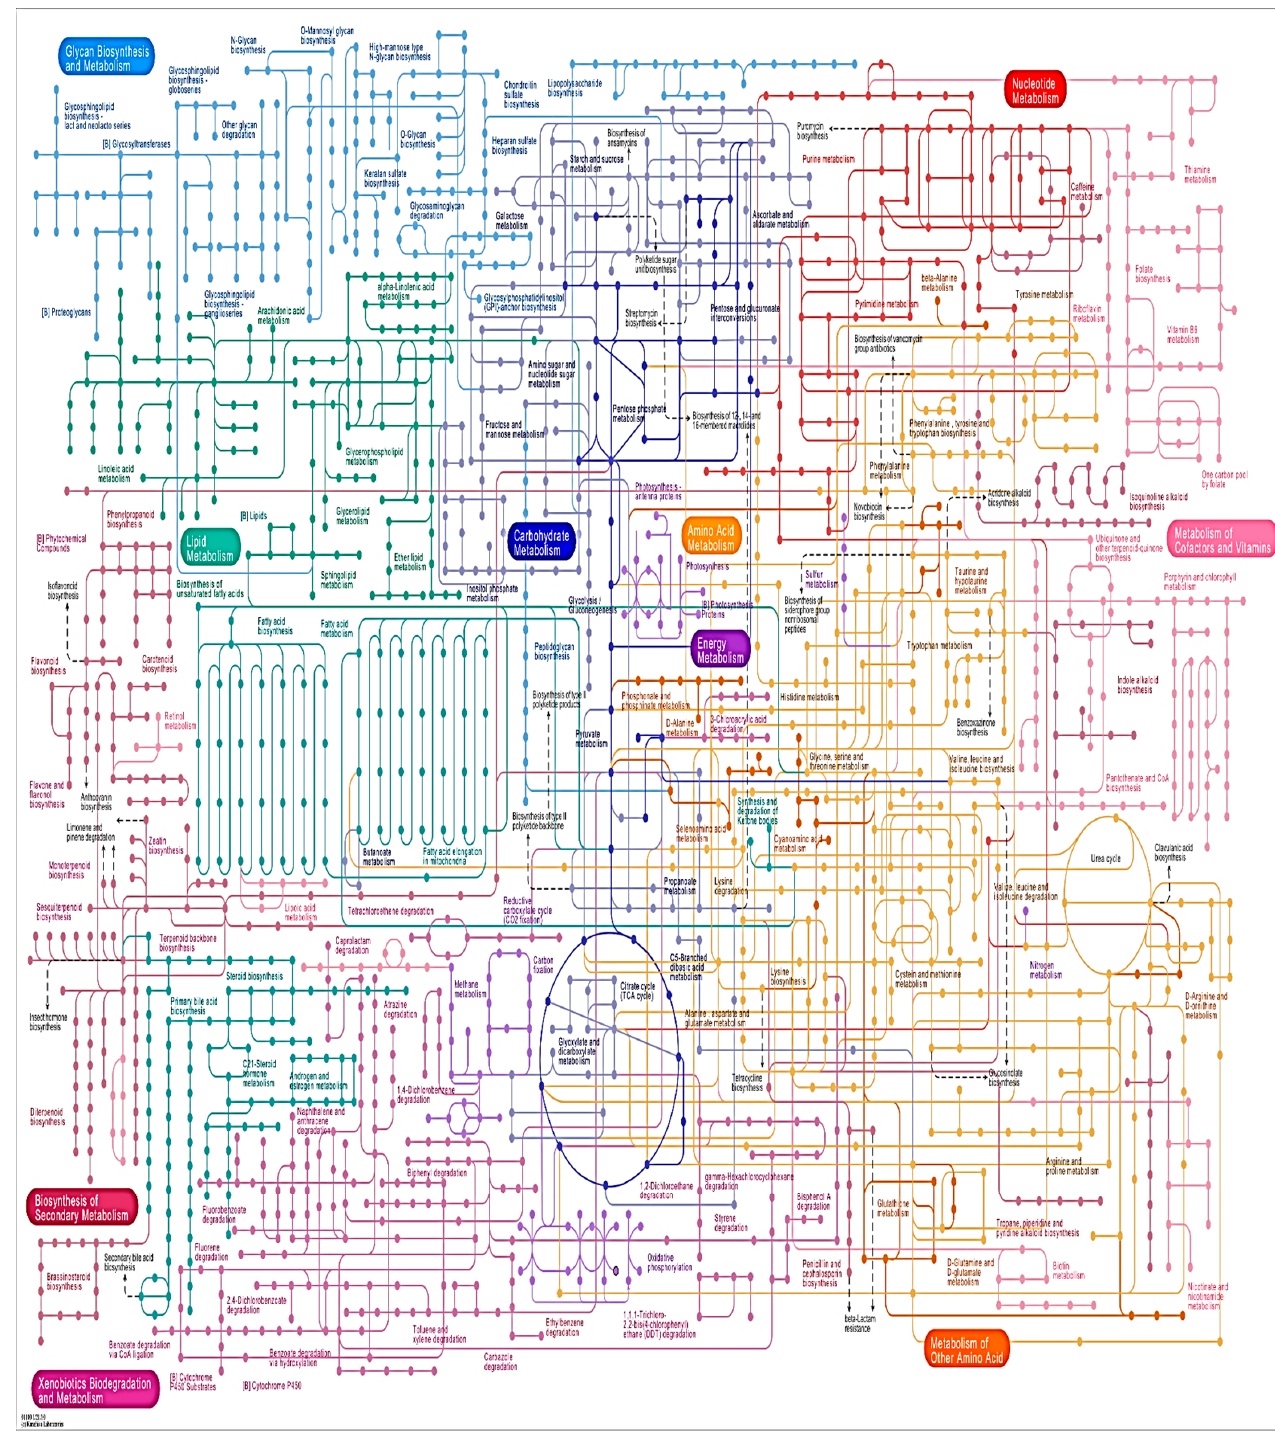
Figure 3. KEGG pathway of carbohydrate synthesis and secondary metabolites.